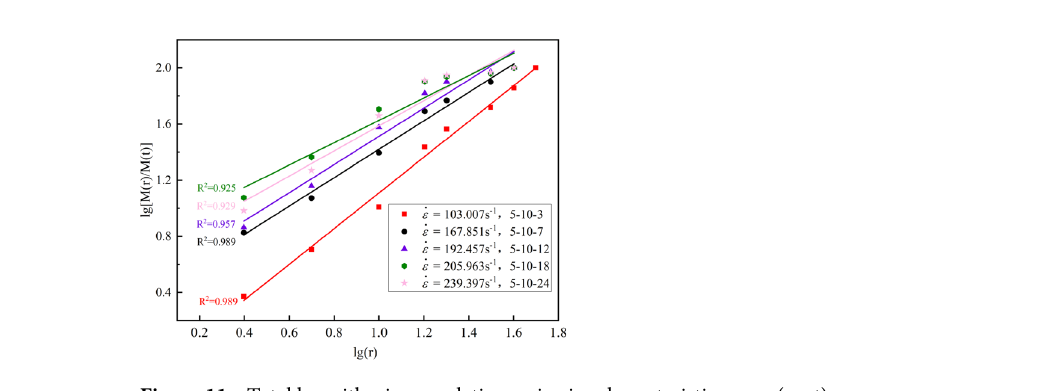
Figure 11. Total logarithmic cumulative grain size characteristic curve